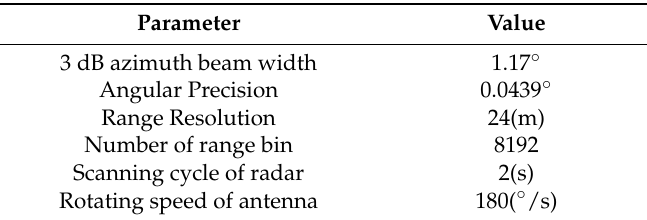
Table A1. Parameters of the radar.